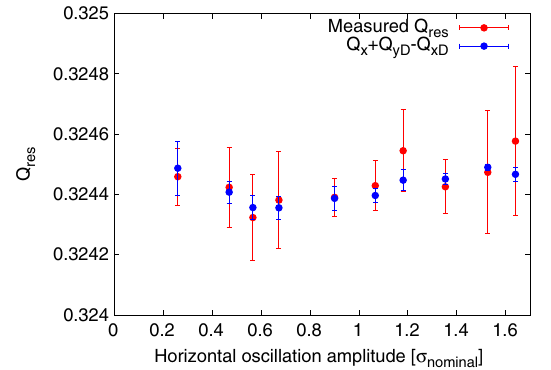
FIG. 12. Frequency of the spectral line ( Q res ) associated with the octupolar resonance Q x (cid:1) Q y (cid:1) Q xD þ Q yD ¼ n directly measured from turn-by-turn data and derived from the measured horizontal natural tune and ac dipole drive tunes. (cid:6) nominal rep- resents the LHC nominal rms beam size for an emittance of 3 : 75 (cid:8) m .